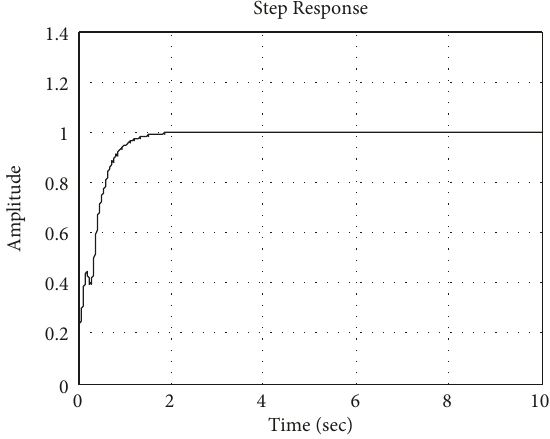
Figure 21: Response curve at 10 times β